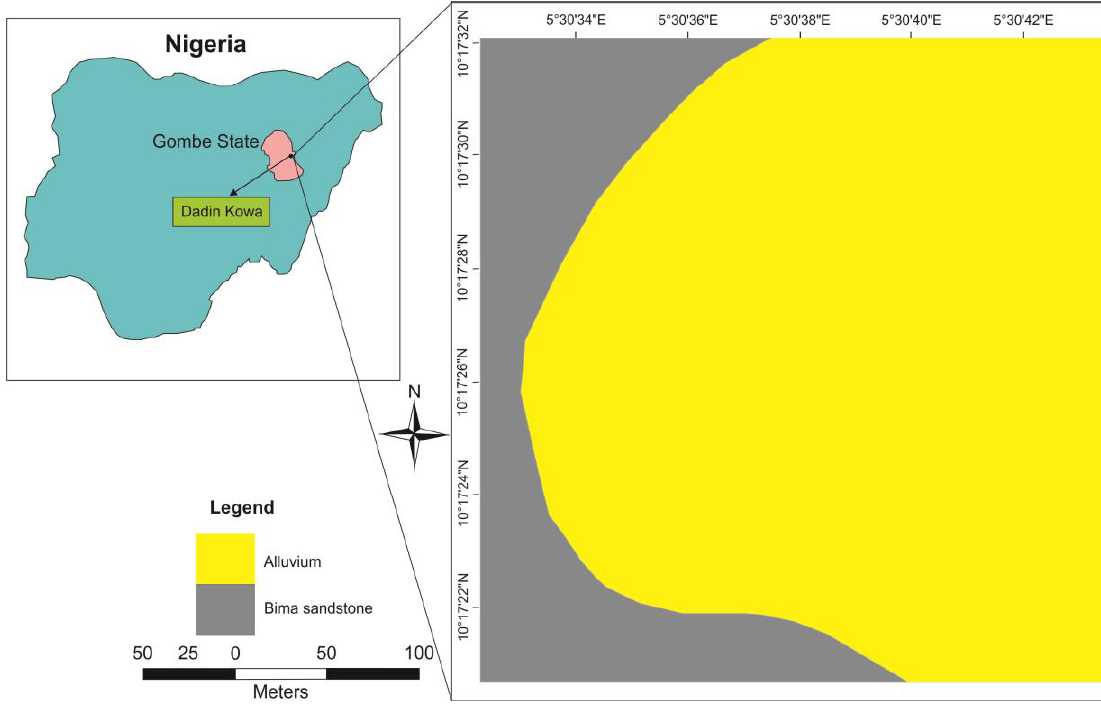
Fig. 2. Geological map of the study